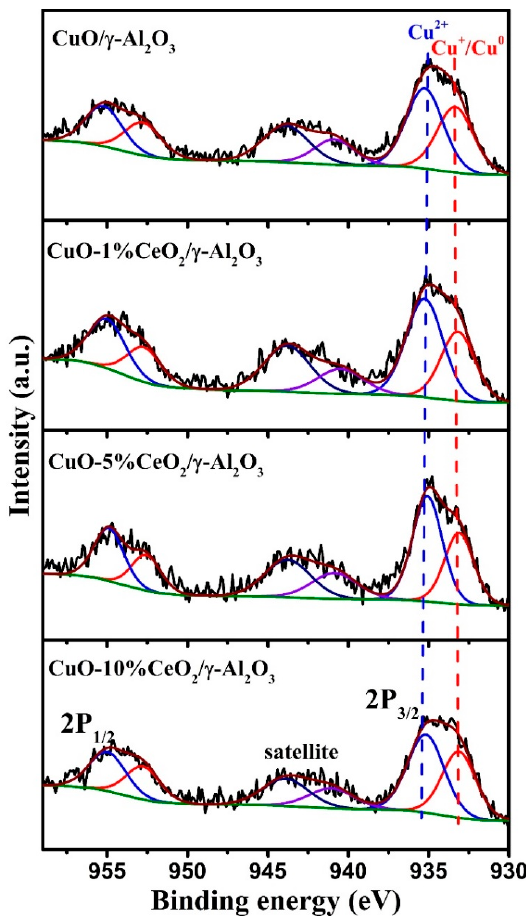
Figure 6. Cu 2p spectra of CuO/ γ ‐ Al 2 O 3 , CuO ‐ 1% CeO 2 / γ ‐ Al 2 O 3 , CuO ‐ 5% CeO 2 / γ ‐ Al 2 O 3 , and CuO ‐ 10% CeO 2 / γ ‐ Al 2 O 3 . CuO-10% CeO 2 / γ -Al 2 O 3